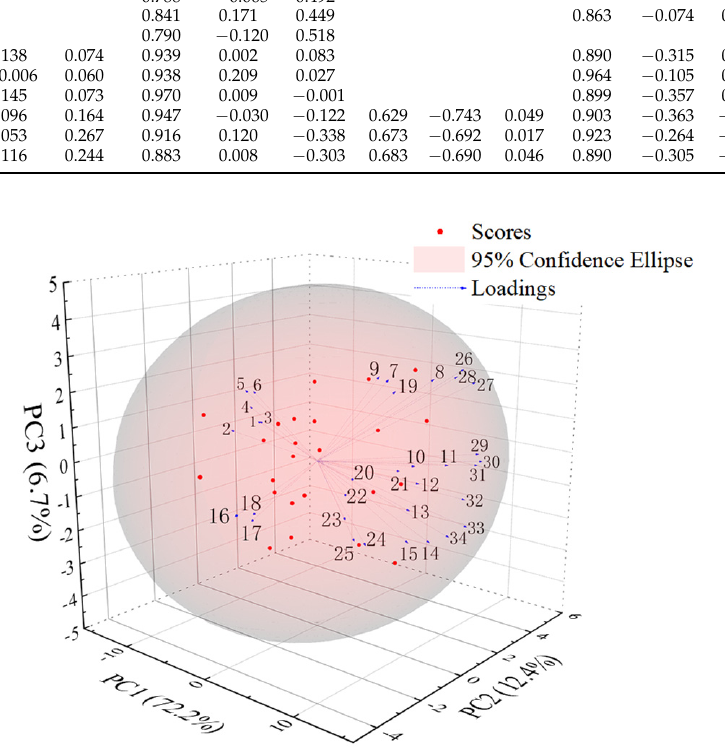
Figure 6. Principal component analysis results of SA-sensitive EEG features. PCA is a method of data dimensionality reduction, which characterizes multiple sets of related data as several unrelated principal components [44,45]. If O i1 is the original